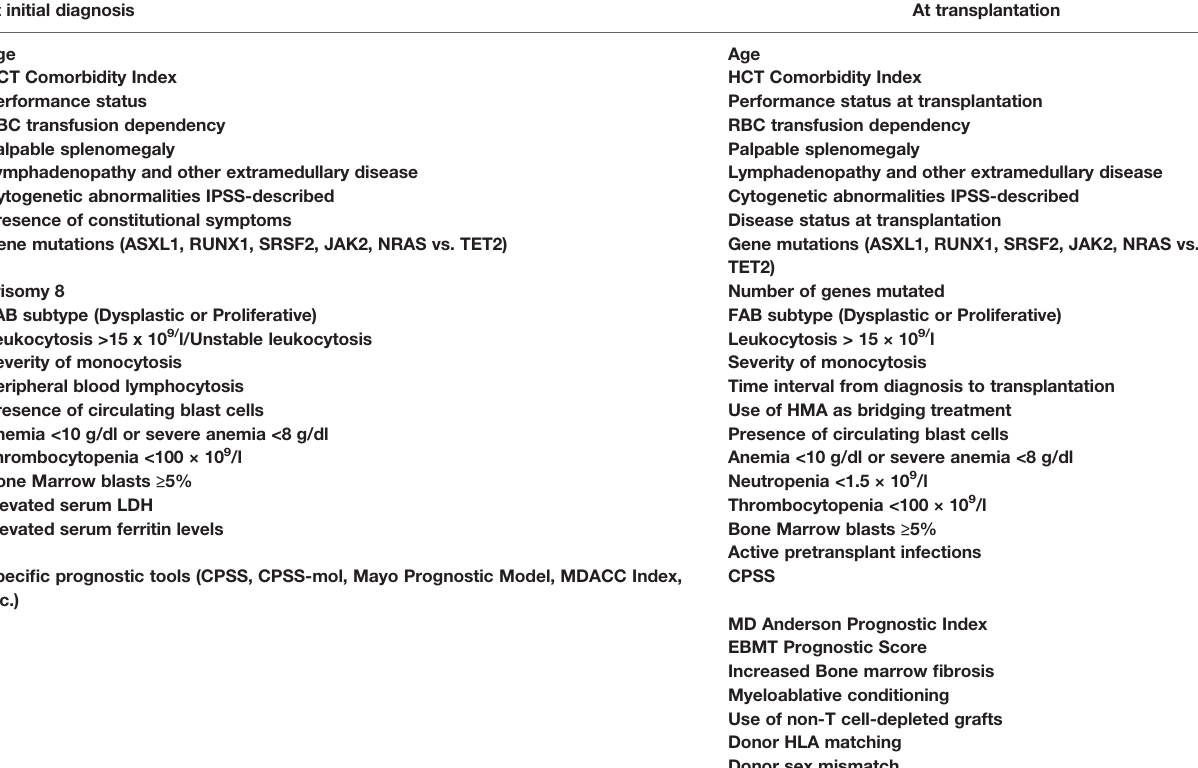
TABLE 5 | Well-recognized prognostic